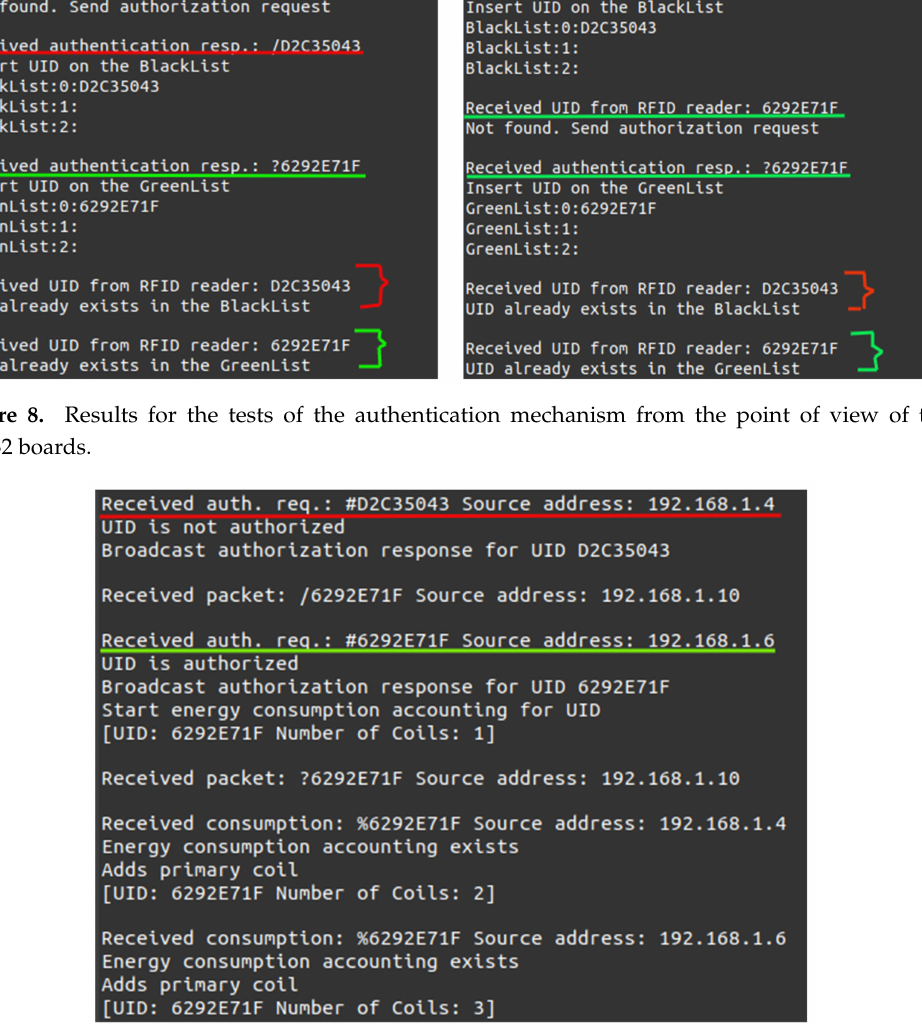
Figure 9. Results for the functional requirement tests from the point of view of the